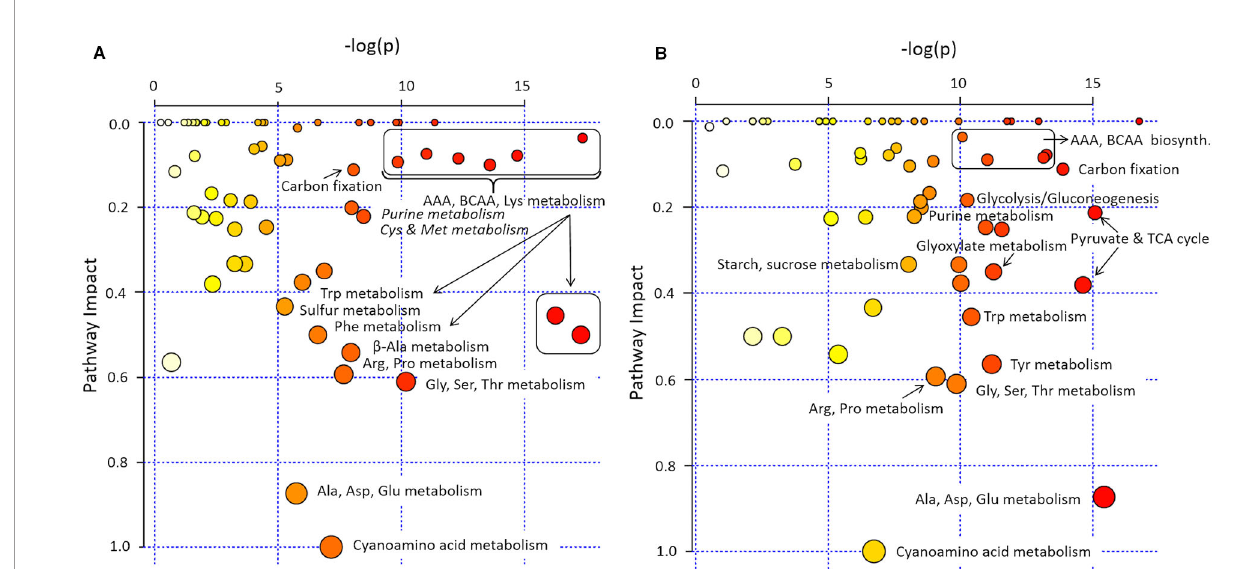
FIGURE 3 | Pathway enrichment analysis of rcd1 primary metabolite pro fi le. (A) Light/control condition, (B) after 4h paraquat (MV) exposure in light (4 h light + 12 h in dark). Size of the node represents the intensity of the impact of plant line on the KEGG pathway based on the impact of each metabolite in a given pathway. Colour scale represents the signi fi cance of the pathway impact [-log(p); natural, e-base-log-transformation]. The list of pathways with their impact and -log(p) values are in Supplementary Table S4